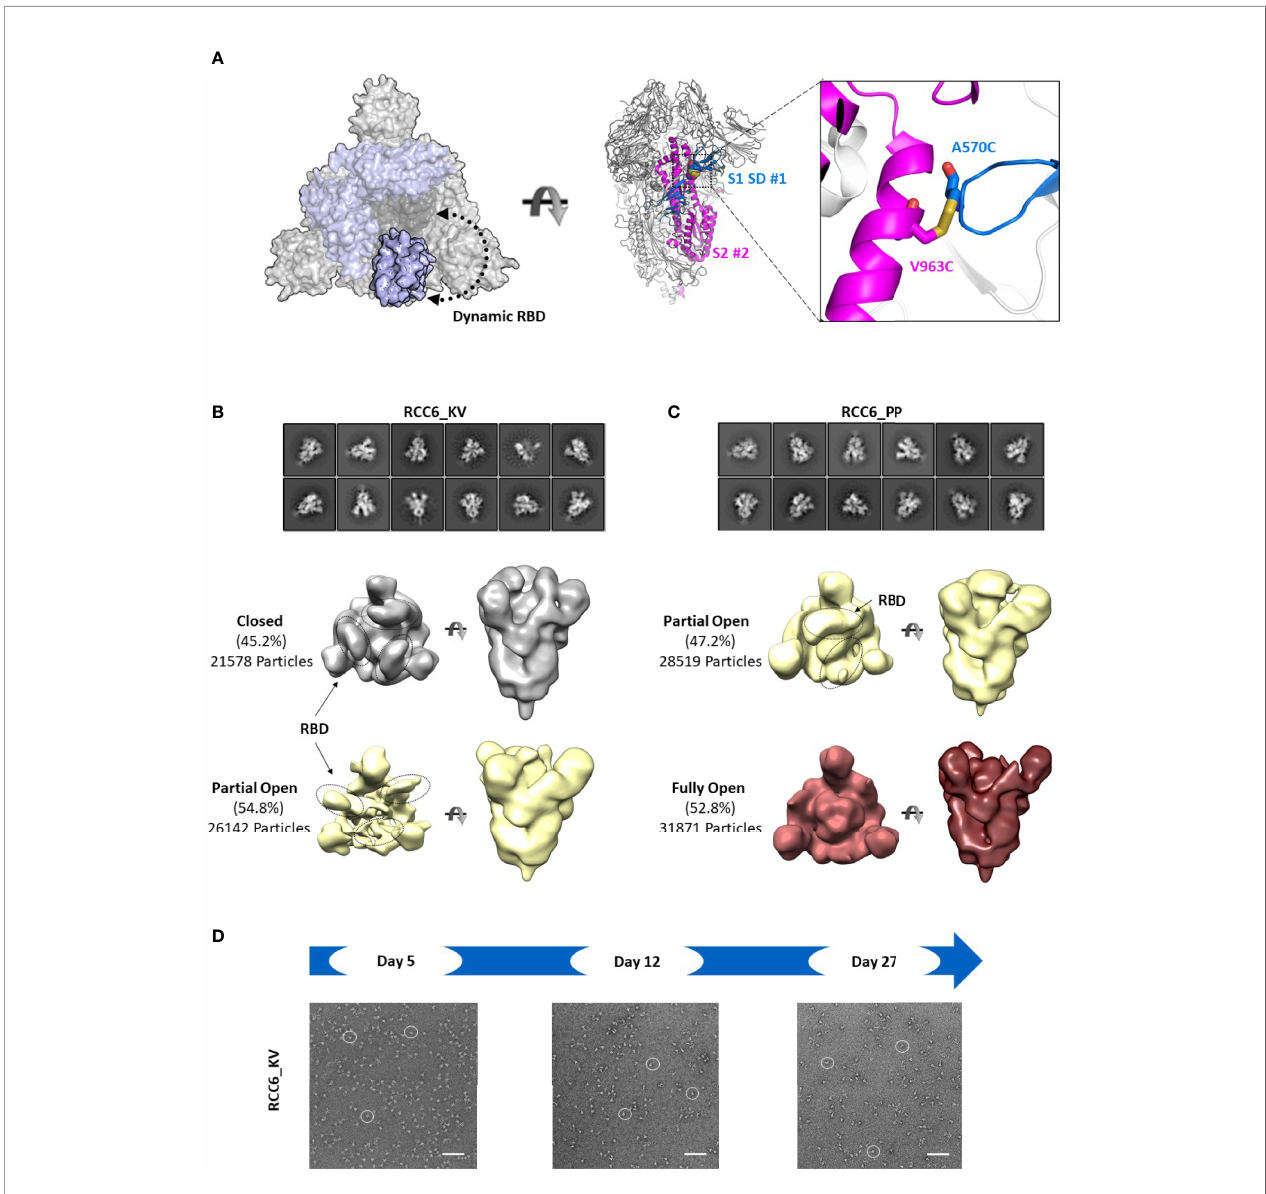
FIGURE 6 | RCC6 stabilizes the prefusion state independent of RBD orientation. Schematic representation of RCC6 disul fi de mutation and expected RBD behavior (modeled from PDB 6VXX and 6VSB) viewed from the “ top ” (left) and “ side ” (center) and zoomed in to show the engineered disul fi de (right) (A) . 2D class averages (top) and 3D reconstruction (bottom) of negative stain EM images of the RCC6_KV designs shows ~45% of the particles maintain all RBDs in the “ closed ” con fi guration, while ~55% of particles are partially “ open ” (B) . In contrast, the RCC6_PP design resulted in 47% of particles in the partially “ open ” state and 53% in a unique “ full open ” state with no RBDs visible (C) . Both RCC6_KV and RCC6_PP had no apparent effect on S2 organization. Similar to RCC3, particles containing the RCC6 design could be identi fi ed by negative stain EM images up to 27 days with no apparent degradation (D) . Scale bars in (D) indicate 100nm and white circles highlight individual